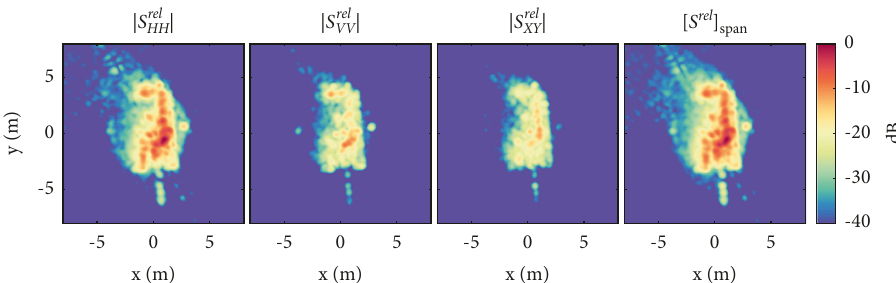
Figure 5: Amplitude and span images of the elements of